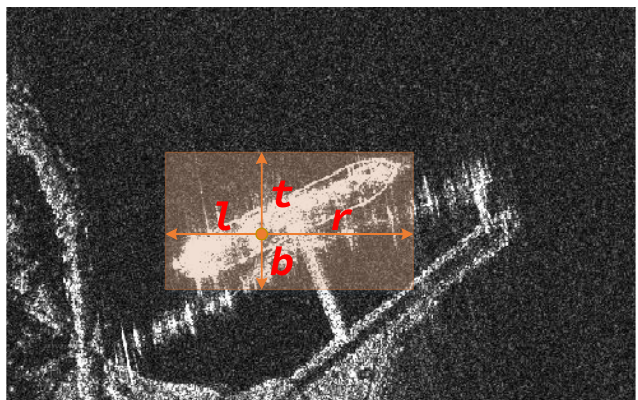
Figure 4. A 4D vector ( l , t , r , b ) encodes the bounding box. ( l , t , r , b ) depicts the relative distances from the object center to the four sides of the bounding box.